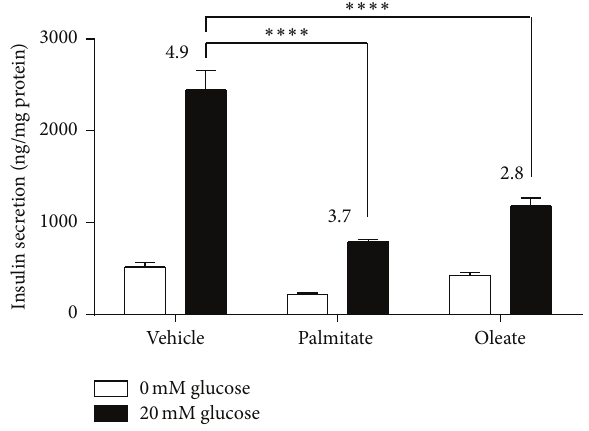
Figure 2: Glucose-stimulated insulin secretion in NEFAs-treated MIN6 𝛽 -cells. MIN6 𝛽 -cells were treated during twenty-four hours with palmitate or oleate (0.5 mM) and then GSIS was evaluated with KRH buffer with or without glucose (20mM) during one hour. Graphbarsrepresenttheinsulinsecretionatlow(whitebars)orhigh glucose (black bars). Graph bars represent mean ± standard errors ofmeasurementsofthreeindependentexperimentsintriplicate.The numbers abovebars representtheStimulation Index (ratioofinsulin secreted in cells with and without glucose). The statistical analysis was made comparing treated versus control at basal and stimulated condition. The symbol ∗∗∗∗ denotes 𝑝 < 0.0001 relative to vehicle condition in one-way